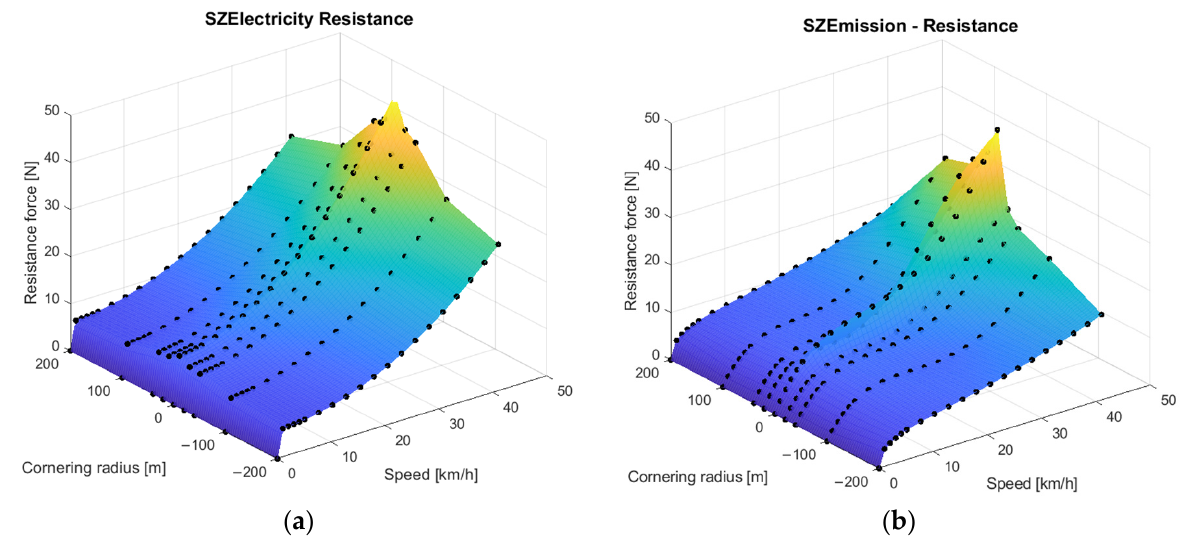
Figure 5. Three-dimensional resistance force model; ( a ) SZElectricity; ( b ) SZEmission.